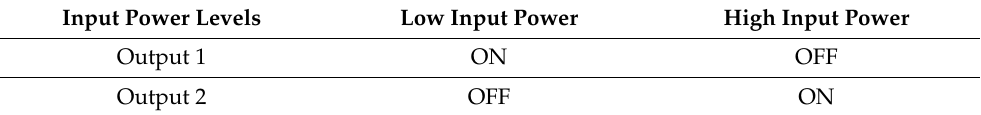
Table 6. Output stats of the proposed switch according to the input power